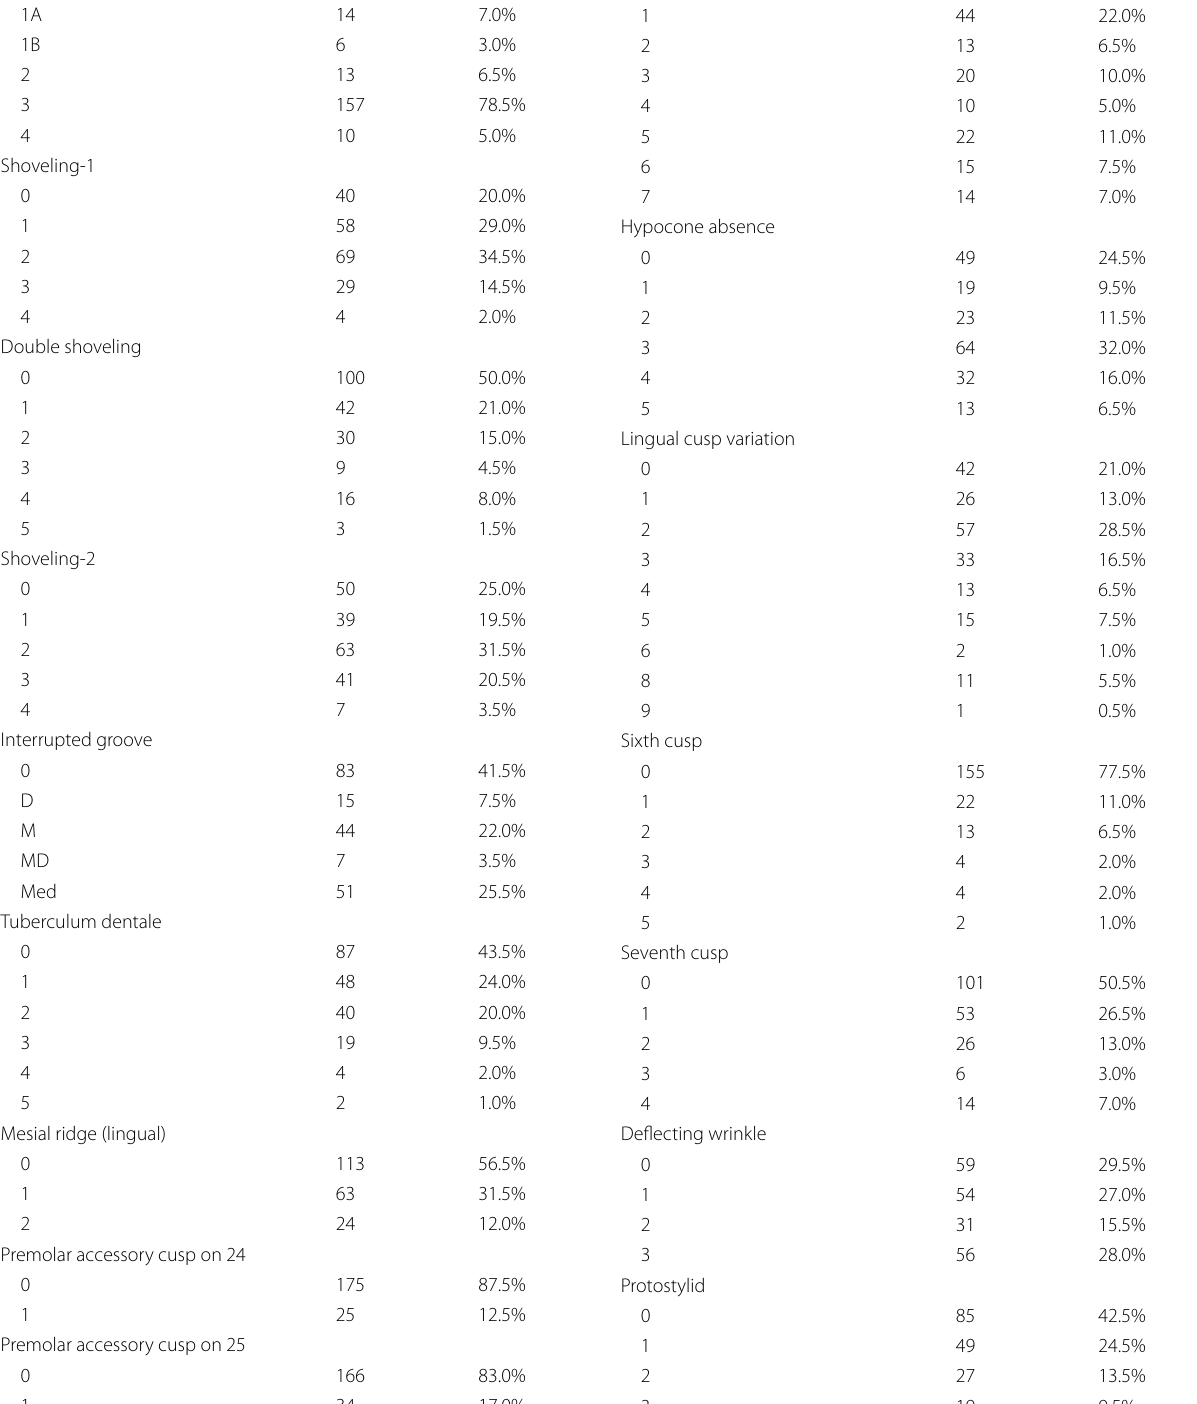
Table 2 Overall frequency distribution of each expression grade of all non-metric dental